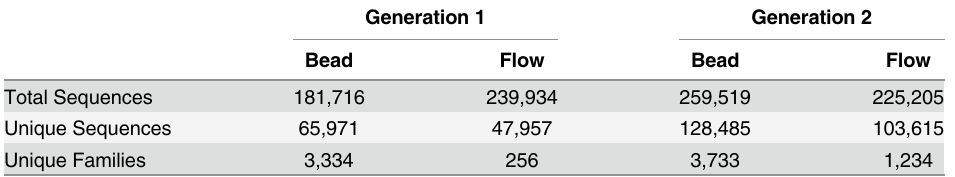
Table 3. High-throughput sequencing. Illumina sequencing statistics for 251 basepair paired end run on MiSeq for six uniquely barcoded libraries. Collectively, 7.2 million pass filter reads were obtained,